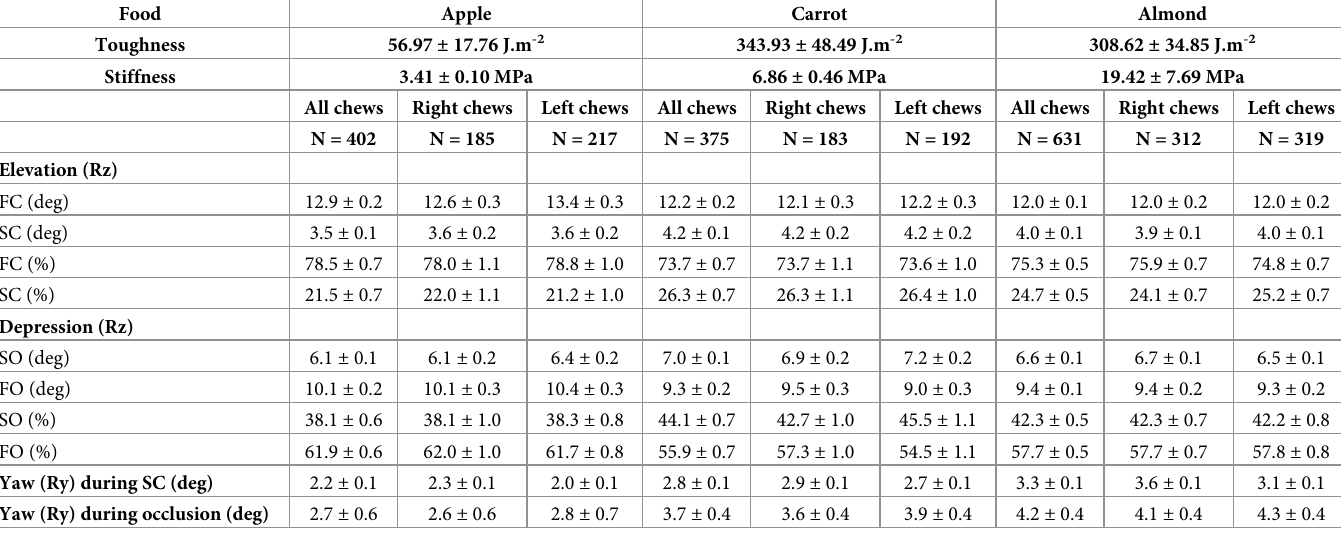
Table entries are mean ± standard error of the mean (s.e.m). Toughness and stiffness data are from [27].